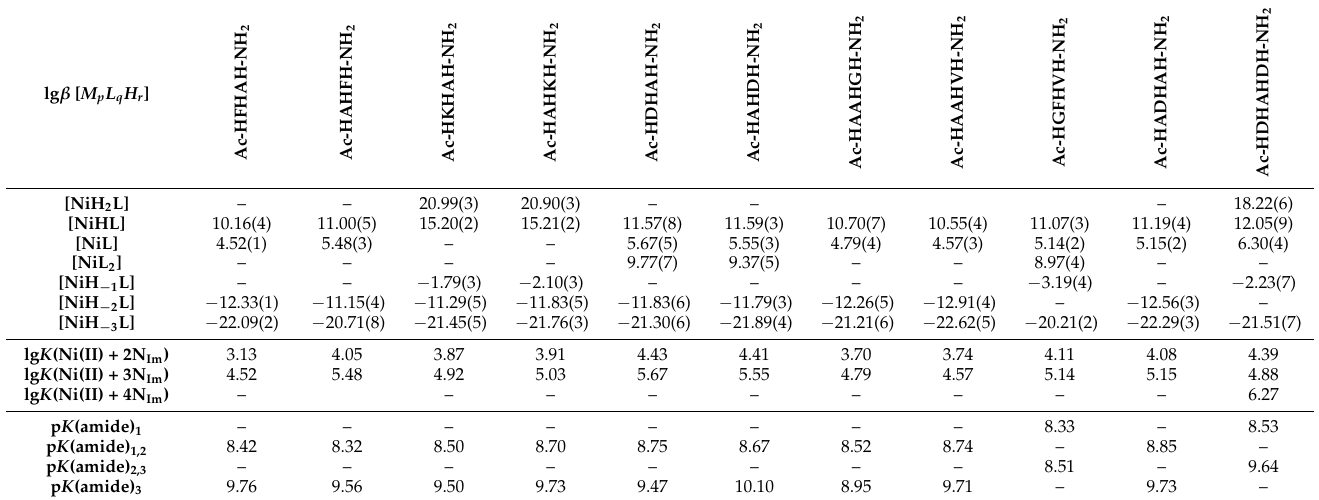
Table 6. Stability constants (log β ) and derived equilibrium constants of complexes formed in the